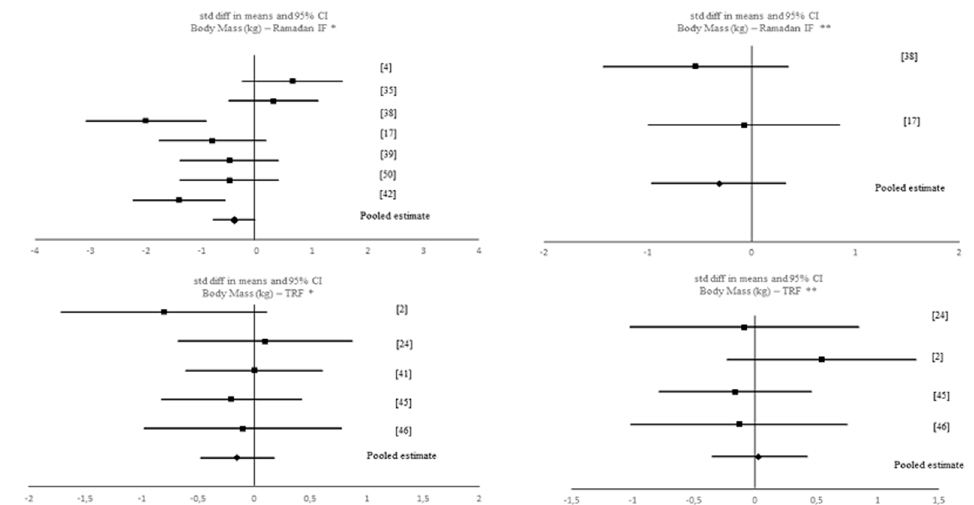
Figure 4. Forest plot of the e ff ects from a random-e ff ects meta-analysis shown as standardized mean di ff erence with 95% confidence intervals on body mass for * Ramadan IF studies and forest plot of the e ff ects from a fixed-e ff ects meta-analysis shown as standardized mean di ff erence with 95% confidence intervals on body mass for TRF studies. For each study, the square represents the standardized mean di ff erence between pre- and post-intervention time points and, whenever possible, between pre-post data of both intervention and control groups with the horizontal line intersecting it as the lower and upper limits of the 95% confidence interval. The rhombi represents the pooled estimated standardized mean di ff erence. Note. * Pre-post tests, IF intervention; ** Pre-post tests, IF intervention vs. control.